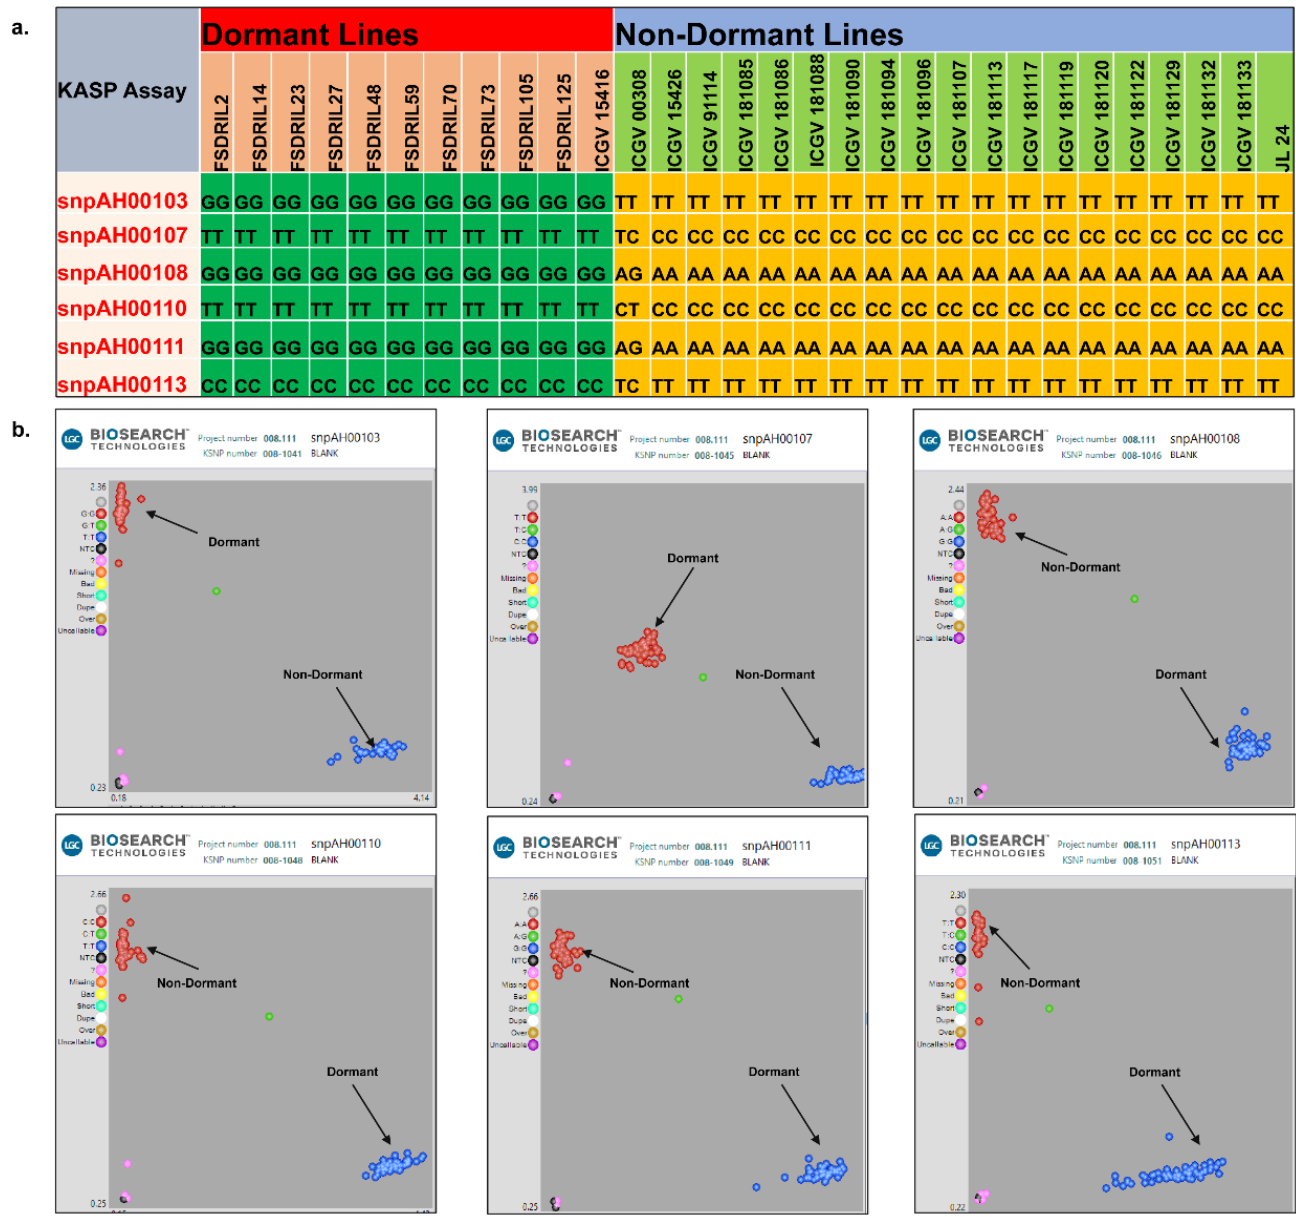
Figure 5. Validation of KASP assays on dormant and non-dormant groundnut genotypes. ( a ) SNP calls and ( b ) Cluster plot distribution across a diverse panel of dormant and non-dormant geno- types.